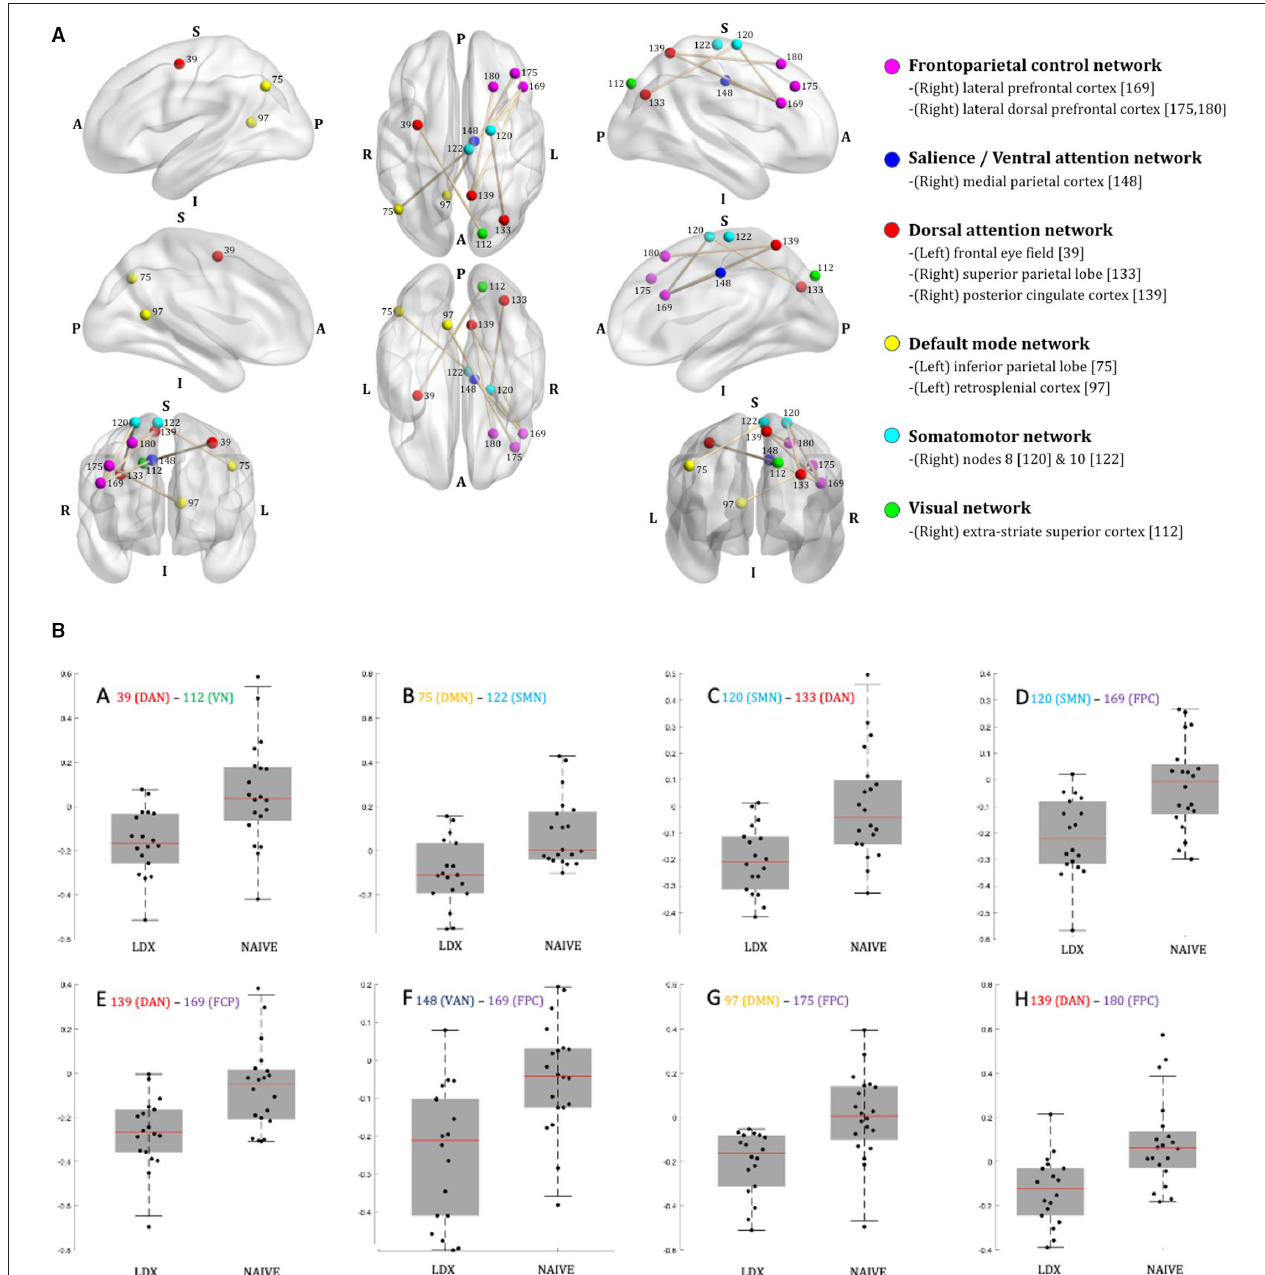
FIGURE 1 | CUNMET neuroimaging results. (A) Projections of the hubs and edges of the pairs of brain nodes [numbered per the Schaefer et al. (18) atlas] that differed significantly on at least 5% of simulations between children treated with lisdexamfetamine vs. medication-naive patients overlaid on semi-transparent brains. The correspondence between Schaefer’s numbers and node names, as well as between the colors of the edges (nodes) and the brain network they belong to [per Yeo et al. (19) brain atlas] are indicated to the right. A, anterior; P, posterior; L, left; R, right; S, superior; I, inferior. For correspondence between the Schaefer nodes and Montreal Neurological Institute brain coordinates see Supplementary Material . Graphs generated with BrainNet Viewer software (https://journals.plos.org/plosone/ article?id = 10.1371/journal.pone.0068910). (B) Box plots of between-group differences in average functional connectivity across the eight pairs of brain nodes [numbered per Schaefer et al. (18)]. LDX = study group 2, patients treated with lisdexamfetamine; naive = study group 4, treatment naive-patients. MPH group (group 1) is not presented here as it did not yield reliable statistically-significant differences in comparisons with LDX and naive, although its average functional connectivities were similar to the connectivities in the naive group. The corresponding brain networks for each node [as per Yeo et al. (19) brain atlas] are indicated by the color codes provided in the right side of (A) . DAN (red) = Dorsal attention network; VN (green) = Visual network; DMN (yellow) = Default mode network; SMN (light blue) = Somatomotor network; FCP (purple-fuchsia) = Frontoparietal control network; VAN (dark blue) = Salience/Ventral attention network. Graphs generated with MATLAB.